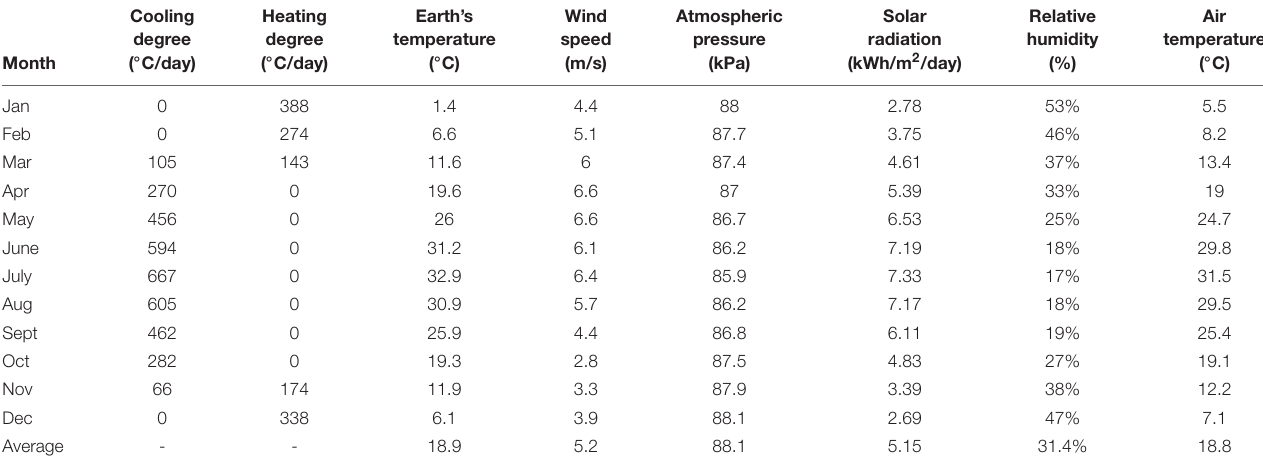
TABLE 1 | Climatic characteristics of Yazd.